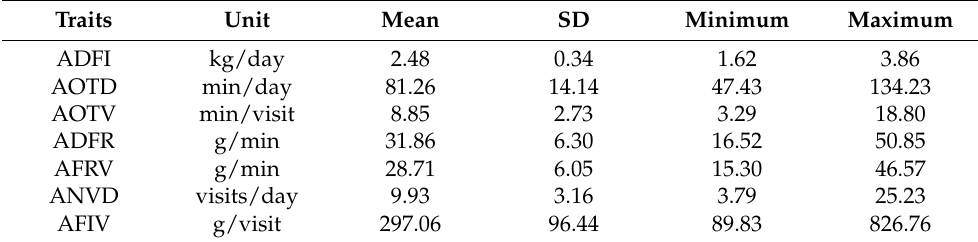
Table 2. Descriptive statistics for feeding pattern traits of Duroc